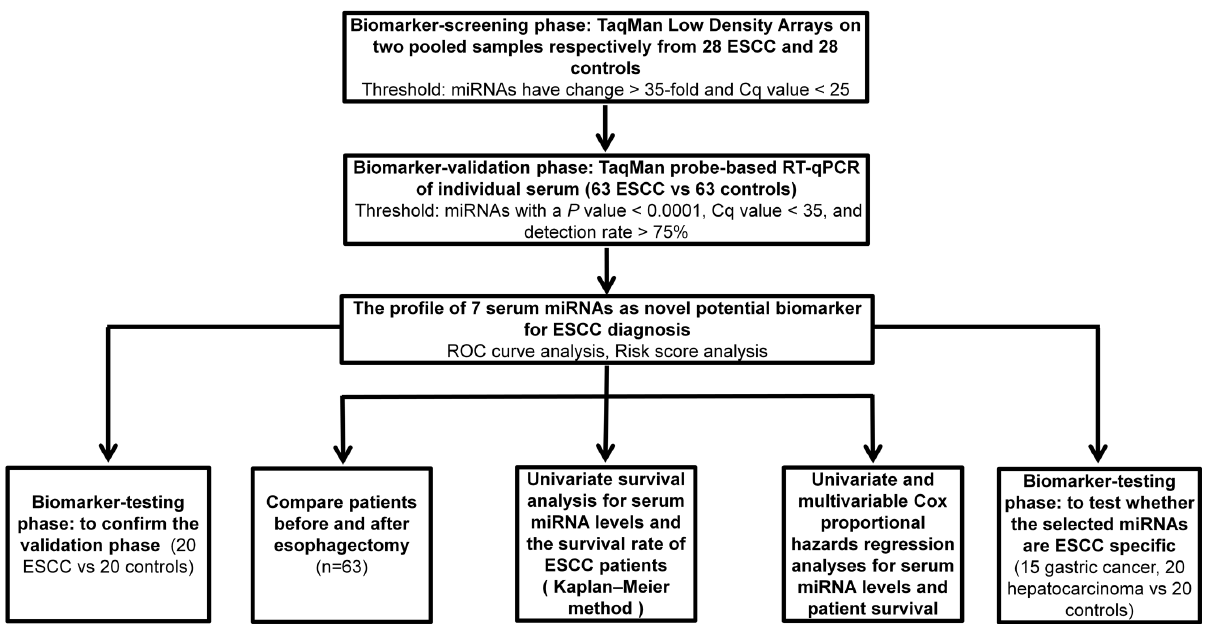
Figure 1. A flow chart of the experimental design.